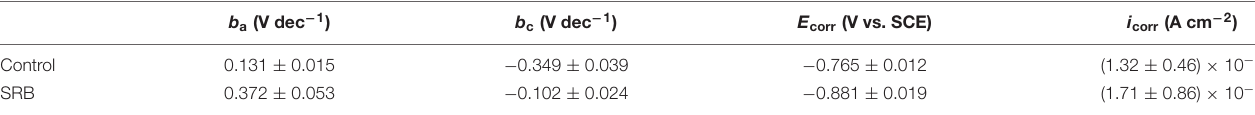
TABLE 4 | Electrochemical parameters fitted from the potentiodynamic polarization data in the absence and presence of SRB after 14 days of